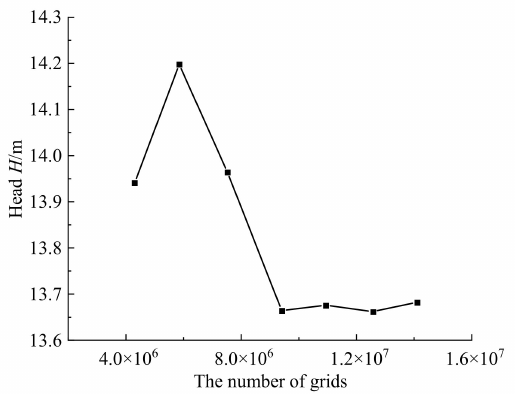
Figure 3. Influence of mesh number on the pump